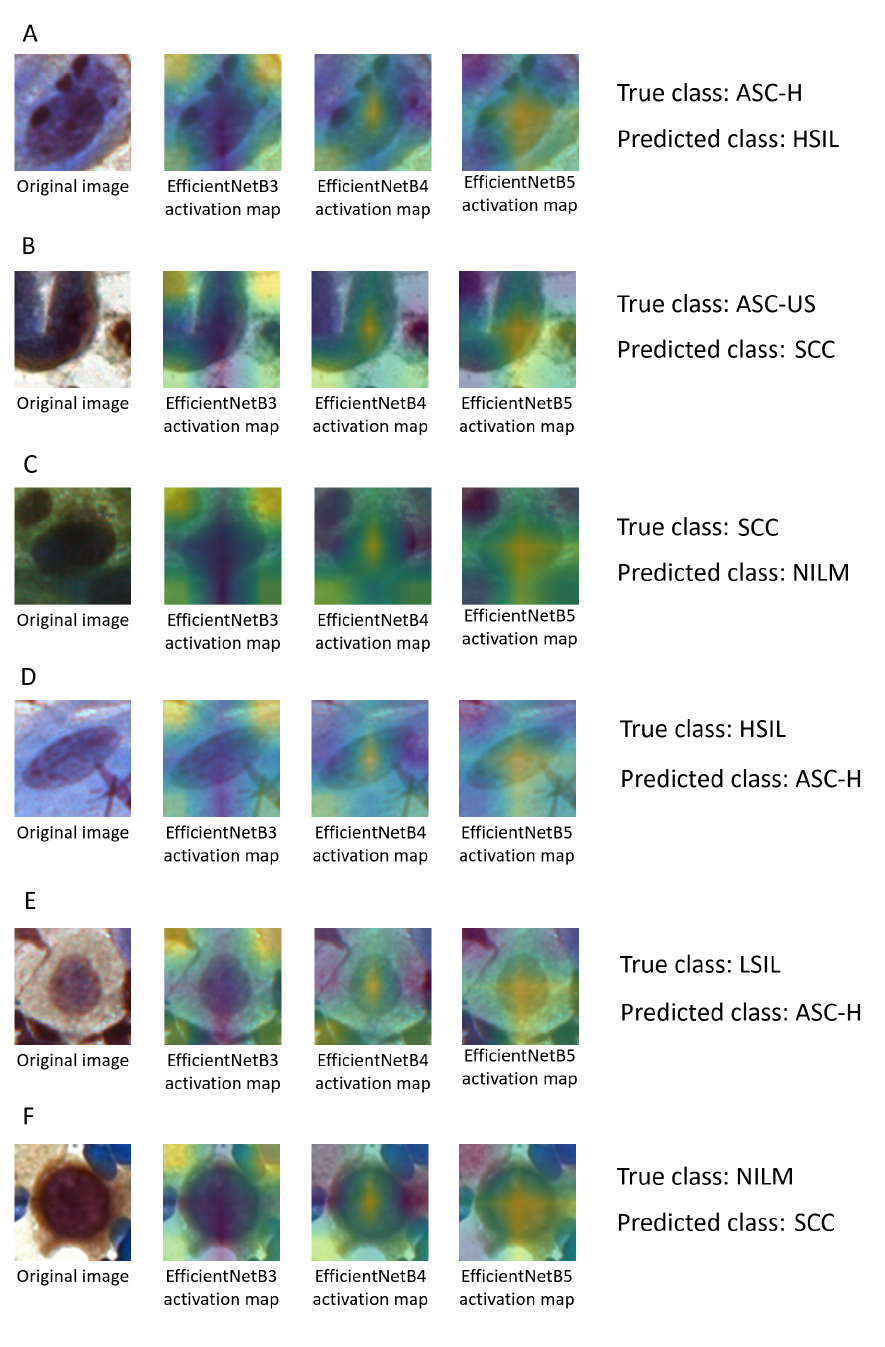
Figure 8. Examples of incorrect classifications: original images, their activation maps according to each architecture used in the ensemble, and their true and predicted classes: ( A ) ASC-H; ( B ) ASC-US; ( C ) SCC; ( D ) HSIL; ( E ) LSIL; ( F )